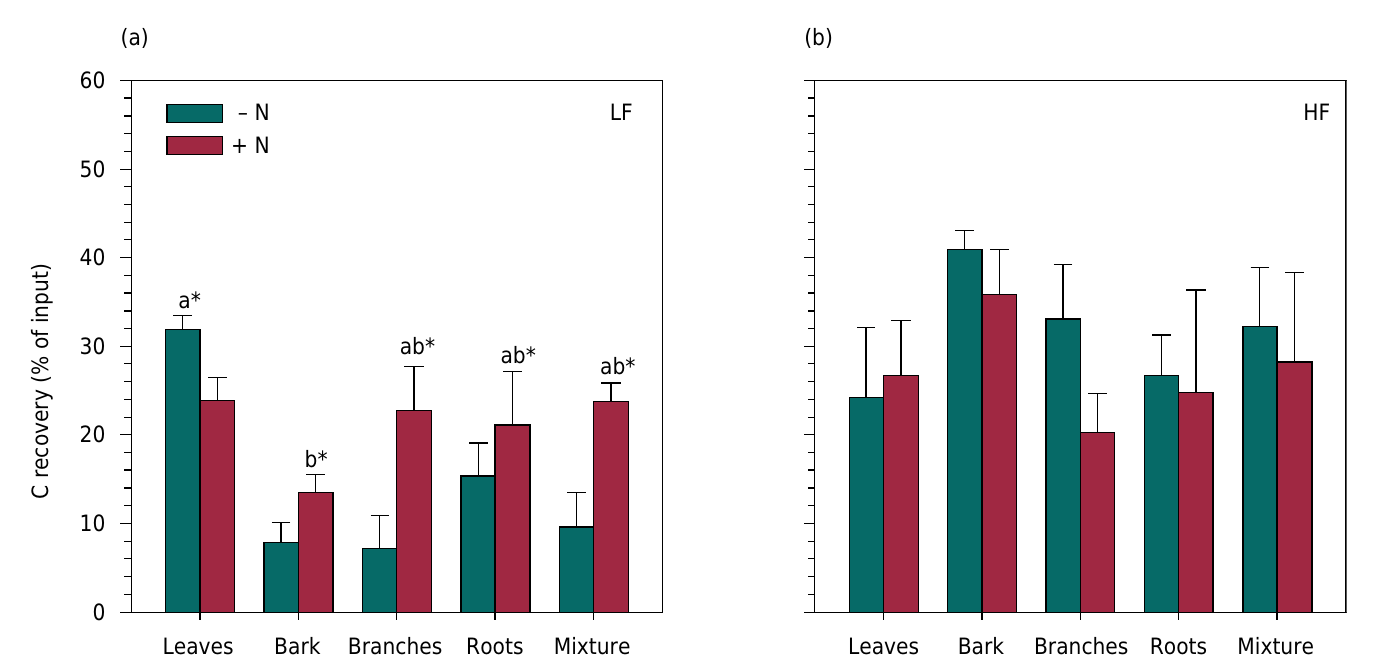
Figure 1. Recovery of residue-derived C (based on natural abundance of C isotopes) in the (a) light fraction (LF) and (b) heavy fraction (HF) of organic matter in soil with (+ N) or without (- N) the addition of mineral N (200 mg kg -1 of N) after 240 days of incubation. Mixture = 12.9, 26.4, 12.7, and 49 % of leaves, bark, branches, and roots residues, respectively. Residues with the same letter are not significantly different (Tukey test, p<0.004). Asterisks indicate a significant effect from the addition of mineral N (p<0.004). No significant differences among treatments were detected for the HF. Error bars denote mean standard deviation (n = 4).